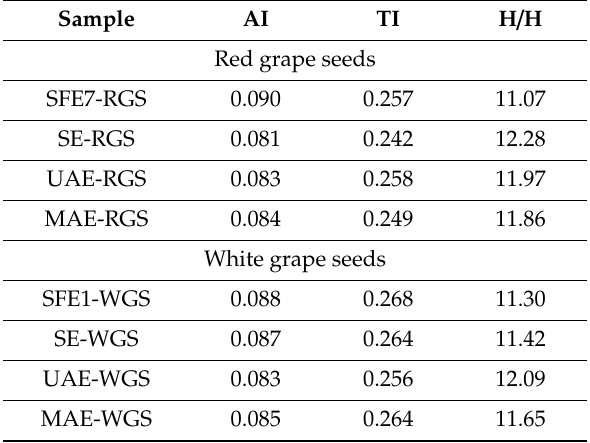
Table 3. Functional quality indices of grape seed oil obtained by di ff erent extraction techniques.